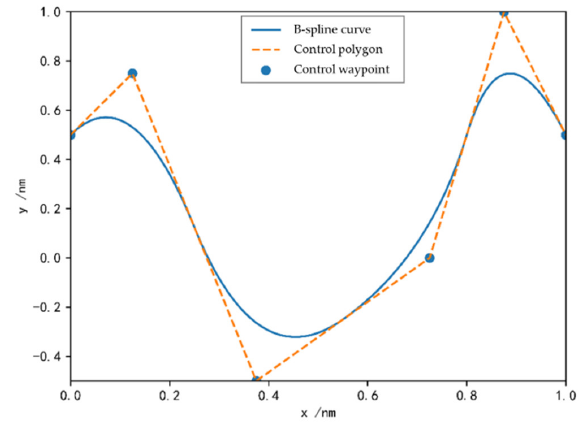
Figure 5. B-spline and its control polygon.